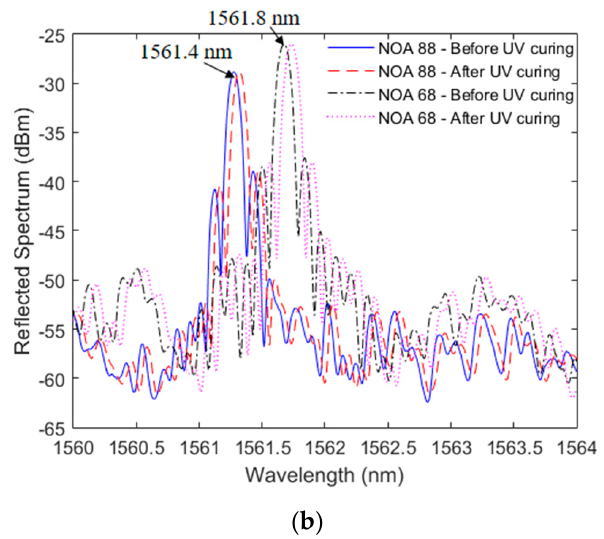
Figure 2. ( a ) Schematic representation of the characterization tests performed in the coated and uncoated FBGs. ( b ) Reflected spectra of the FBG samples before and after the UV curing.